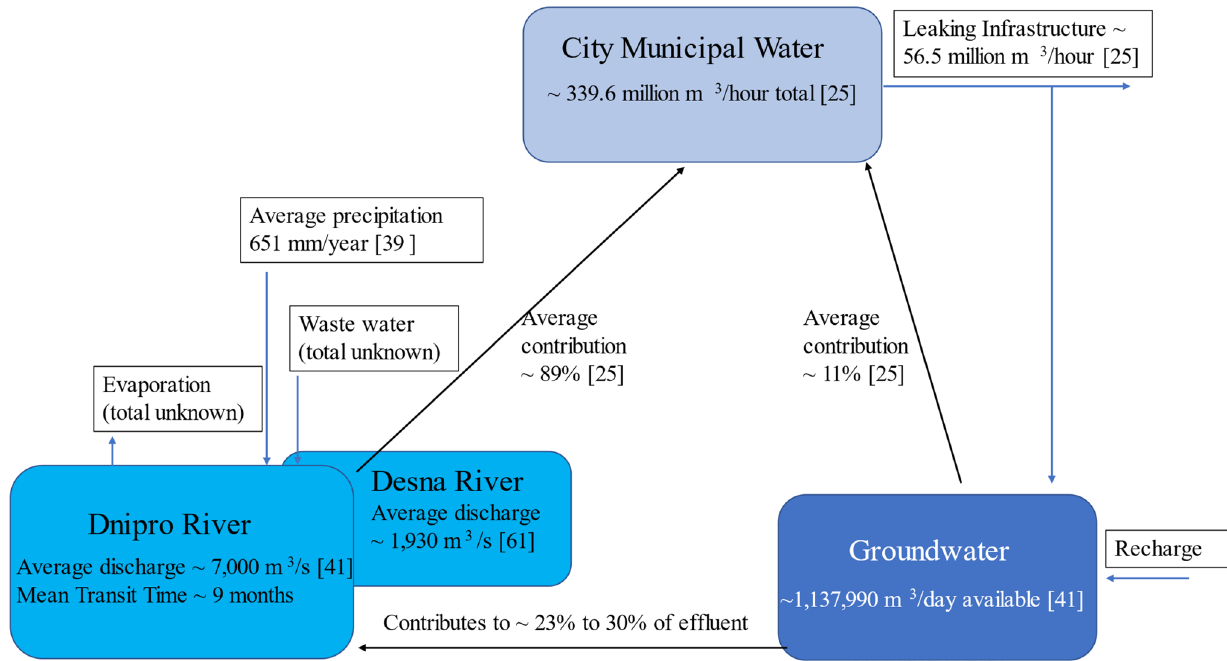
Fig. 5 Schematic of sources to Kyiv water supply. Shown are inputs to the sources and amounts if they are publicly known, percent contri- bution of the sources to the water supply, and amount output from the supply, including losses from leaking infrastructure [25, 39, 41,